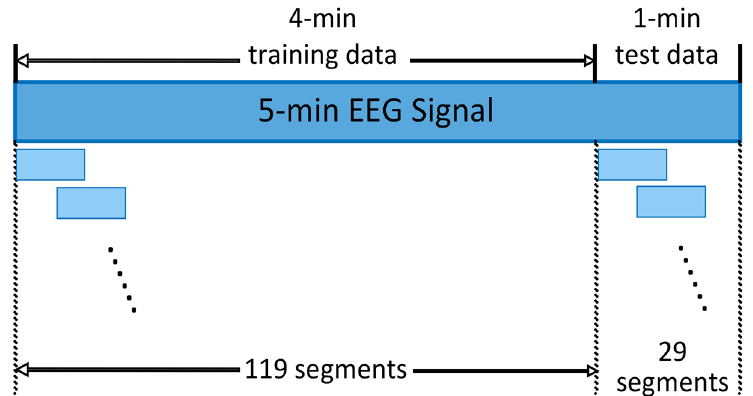
Figure 2. EEG Data Figure 2. EEG Data Segment.